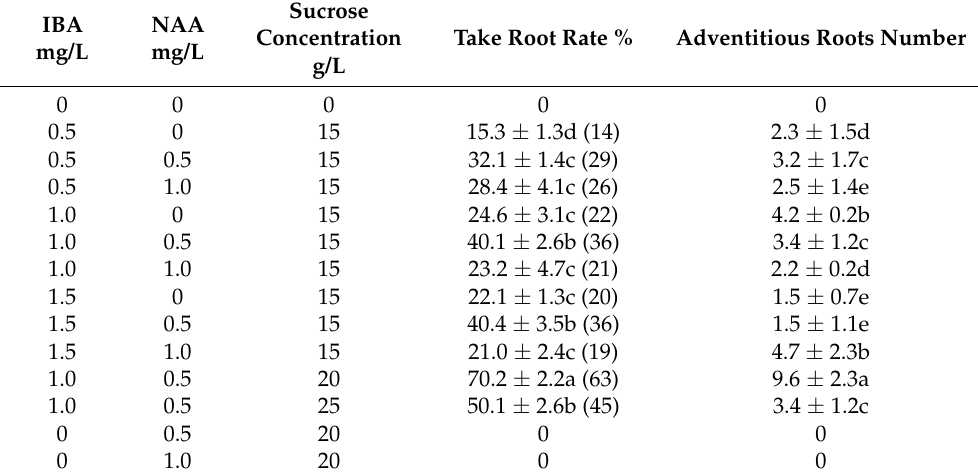
Table 8. Effects of different basic media and hormones on rooting culture of D. lotus